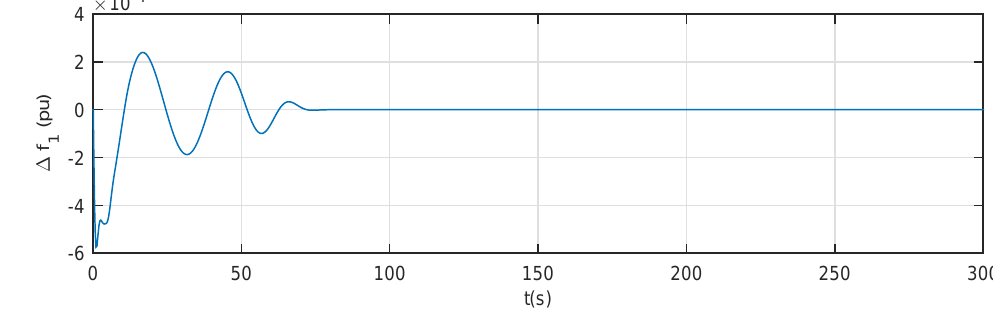
Figure 6. Frequency responses area 1 of a two-area traditional LFC model with time-varying